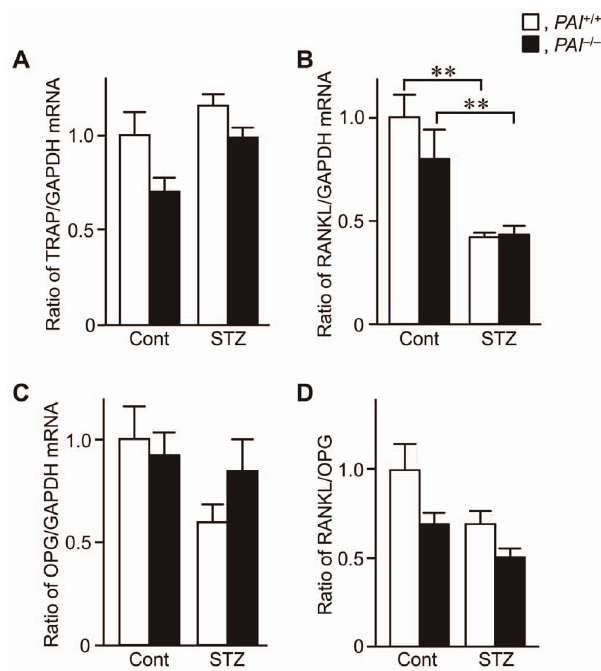
Figure 5. Effects of PAI-1 deficiency on bone resorption markers during bone repair in female mice. (A–C) The levels of TRAP, RANKL, and osteoprotegerin (OPG) mRNA at the damaged site on day 7 after a femoral bone defect in female PAI-1 + / + and PAI-1 2 / 2 mice with or without STZ treatment. Data are expressed relative to GAPDH mRNA values, and are expressed as mean 6 SEM. (D) The ratio of RANKL/OPG mRNA at the damaged site on day 7 after a femoral bone defect in female PAI-1 + / + and PAI-1 2 / 2 mice with or without STZ treatment. ** p , 0.01 (n=5–7 in each group). Cont, control. (Fig. 5C, D). PAI-1 deficiency did not affect the levels of RANKL mRNA suppressed by STZ treatment (Fig. 5B).